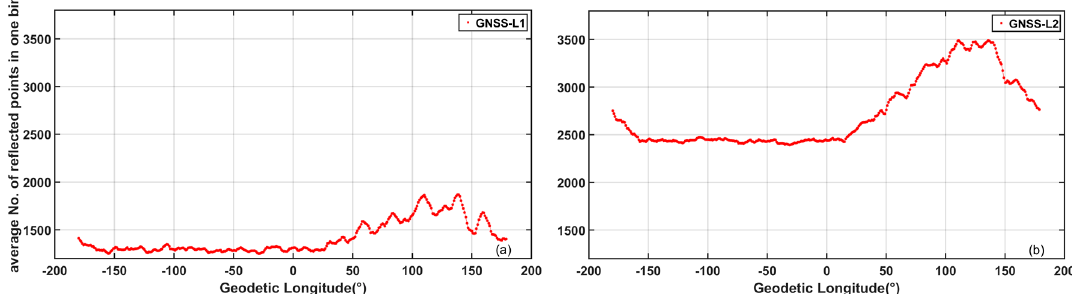
Figure 8. Average numbers of four-system GNSS-R specular reflection points in 1° × 1° grids at different longitudes during a complete 13-day cycle at the GPS L1 ( a ) and L2 ( b ) frequencies.